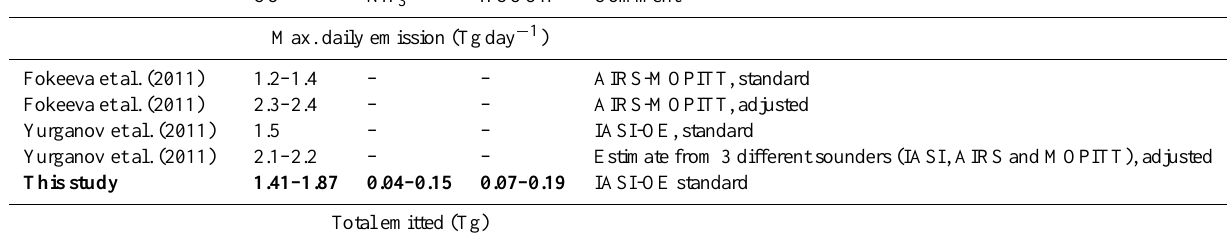
Table 1. Comparative analysis of total emissions of CO, NH 3 and HCOOH from current and previous studies of the 2010 Russian wildfires. CO NH 3